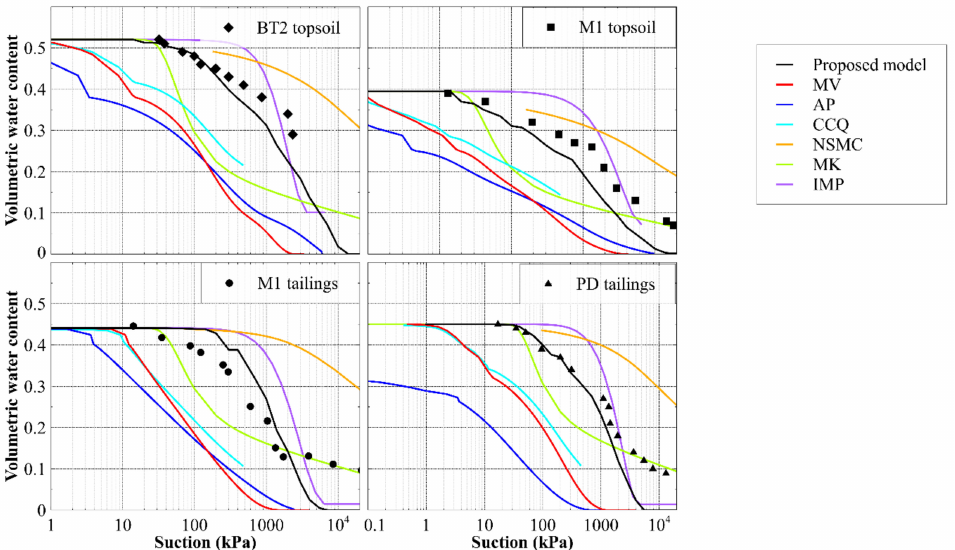
Figure 13. Water retention curve predictions for the materials presented in Figure 12 from the proposed model and various models from the literature. Refer to Figure 11 for the GSD of each material, and Appendix B for the model parameters used.